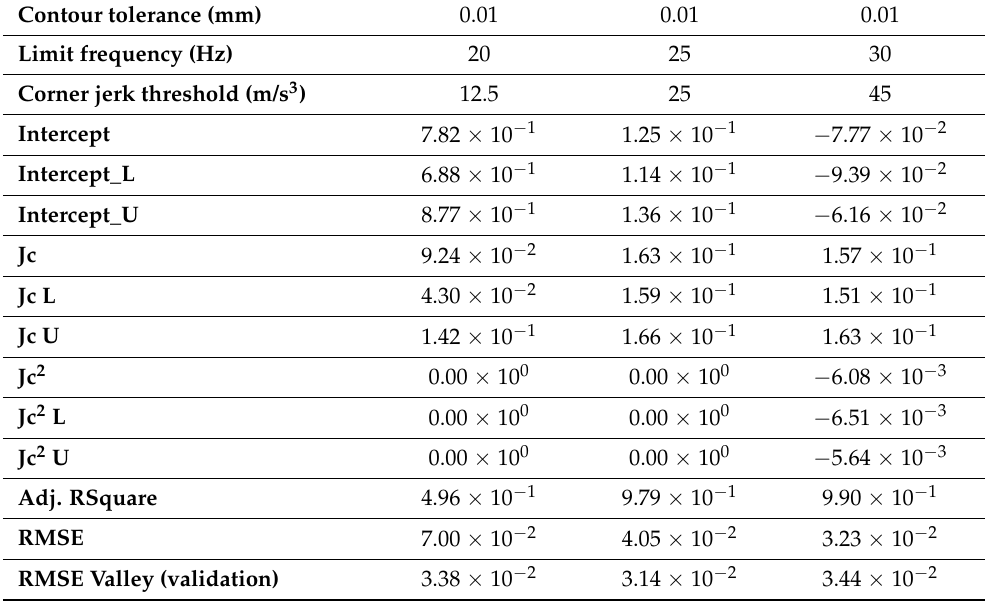
Table A2. Parameters of regression models describing the dependence of the TV coefficient on the corner jerk limit (denoted by J c ), results for contour tolerance of 10 µ m. Postfixes L and U denote the lower and upper limits of the 95% confidence intervals,